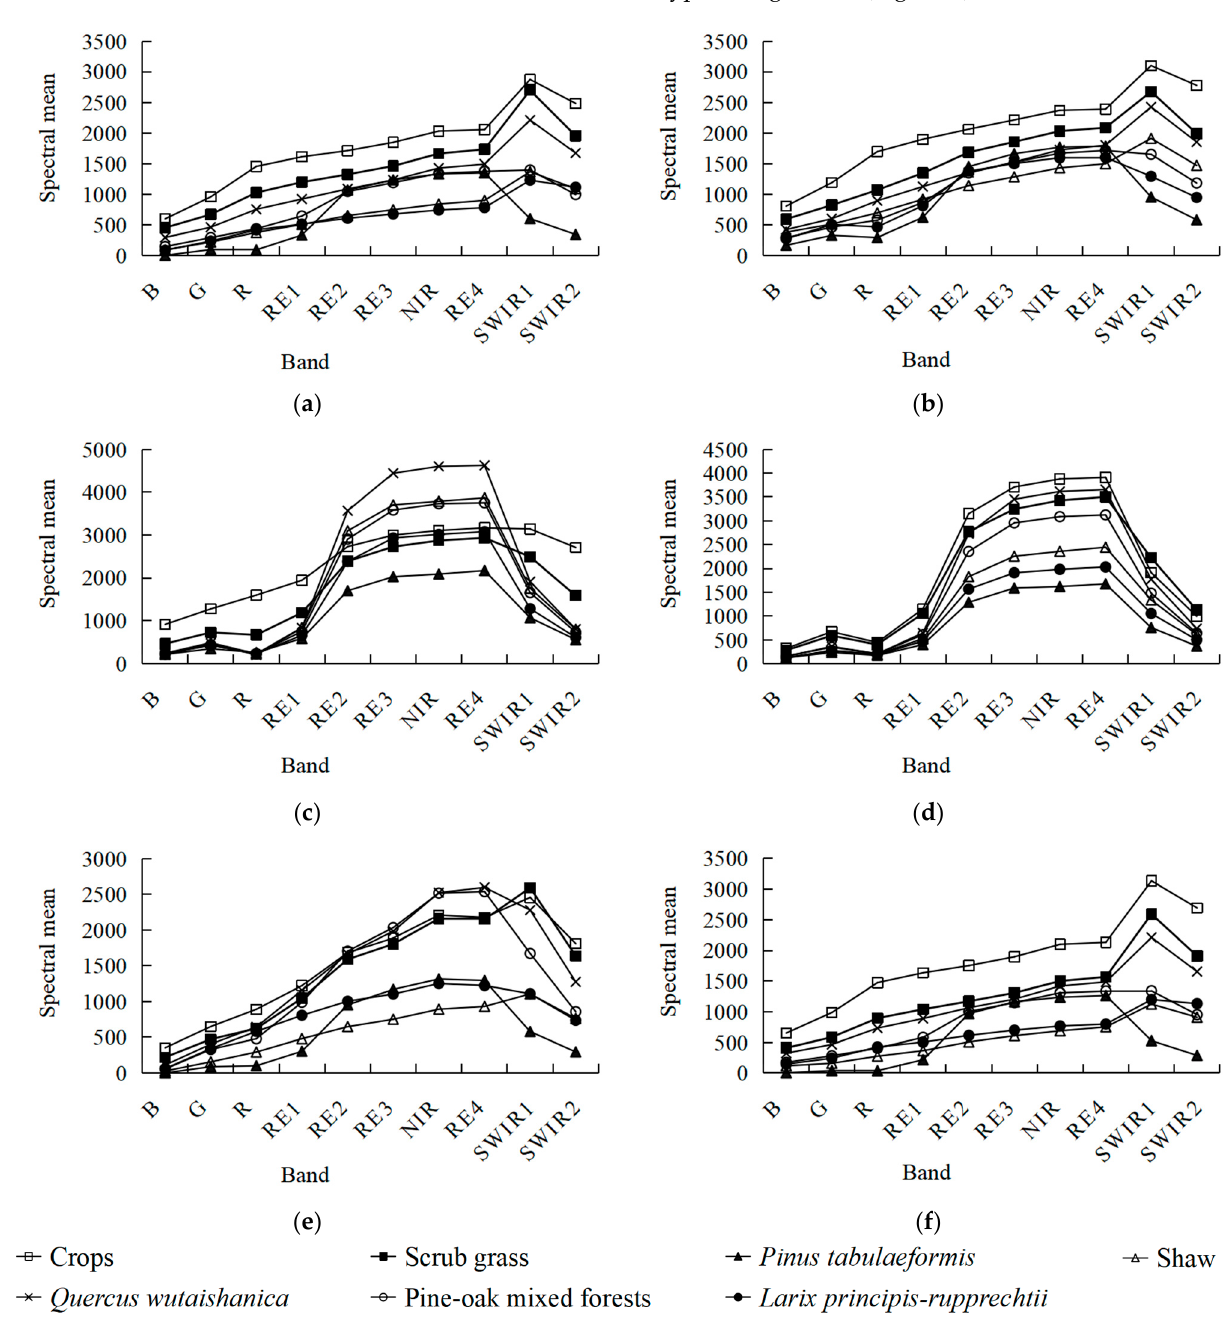
Figure 3. Spectral feature curve of vegetation types on ( a ) 19 February, ( b ) 25 April, ( c ) 4 June, ( d ) 28 August, ( e ) 17 October, ( f ) and 21 December.